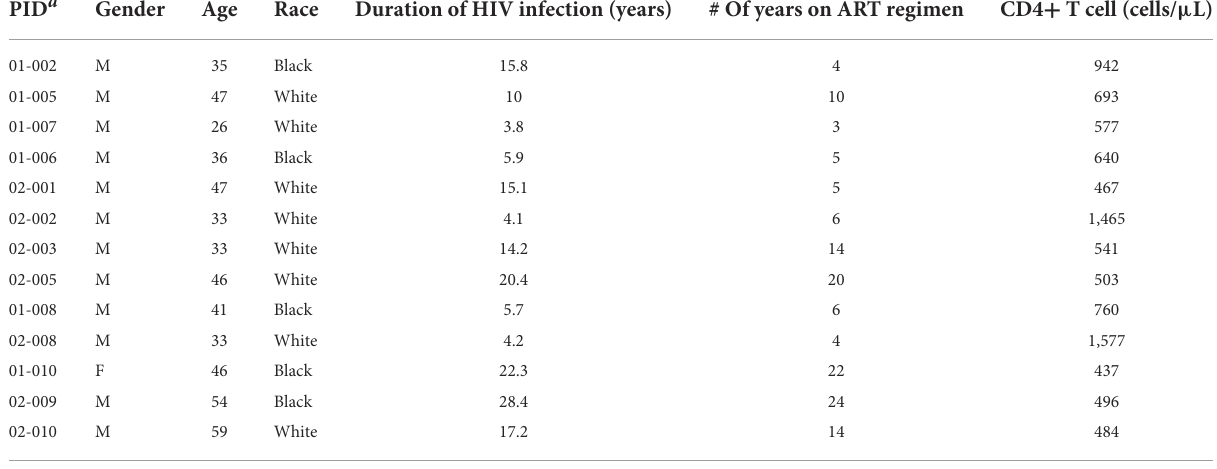
TABLE 1 Demographics of participants enrolled in Phase 1 study.